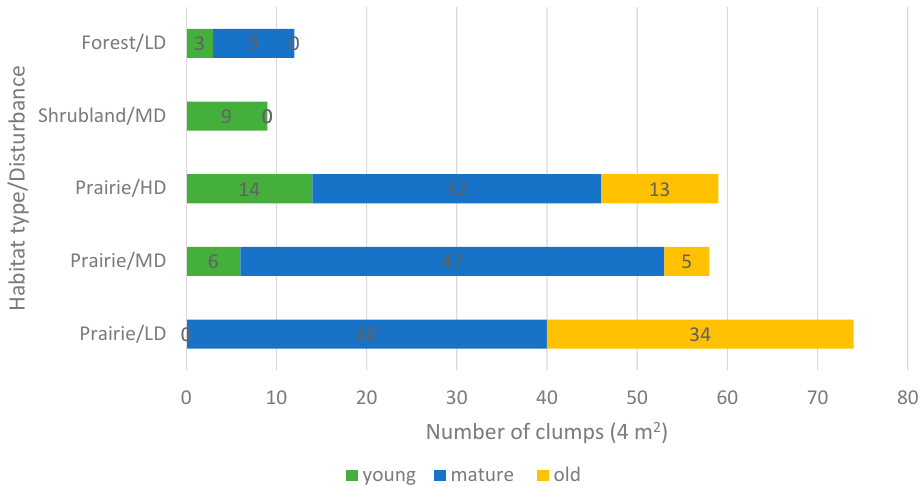
Figure 5. Distribution of clumps of different age in Anemone patens in habitats with varying levels of disturbance. Prairie: LD—low disturbance (Battlefords Provincial Park), MD—moderate disturbance (Crocus Prairie Conservation Area), HD—high disturbance (Redberry Lake Biosphere Reserve); Shrubland: M—medium disturbance (Cranberry Flats Conservation Area); Forest: LD—low disturbance (Prince Albert National Park).